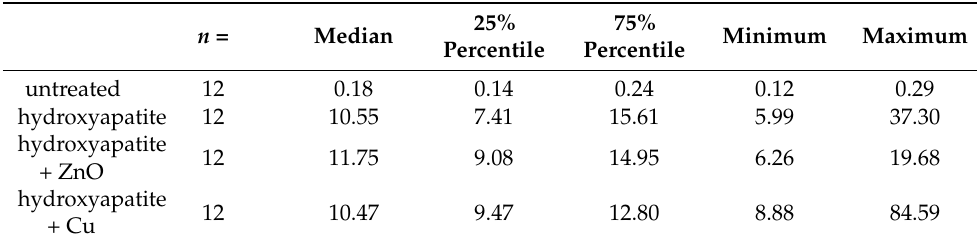
Table 2. Descriptive analysis of surface roughness presented in Figure 2C. Median, percentiles, and minimum and maximum Sa values, measured in µ m, are shown.